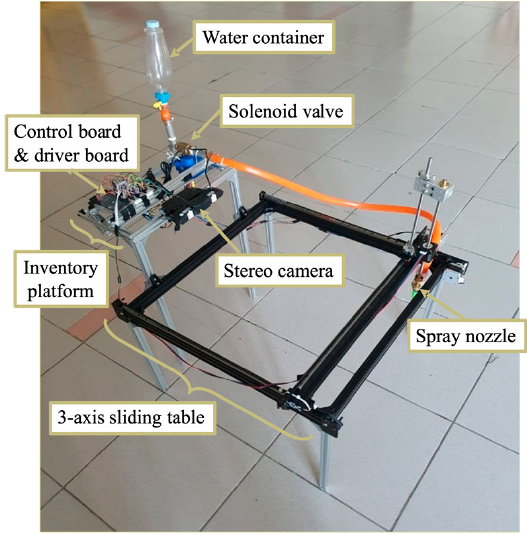
Figure 16. The platform of the automatic watering system.